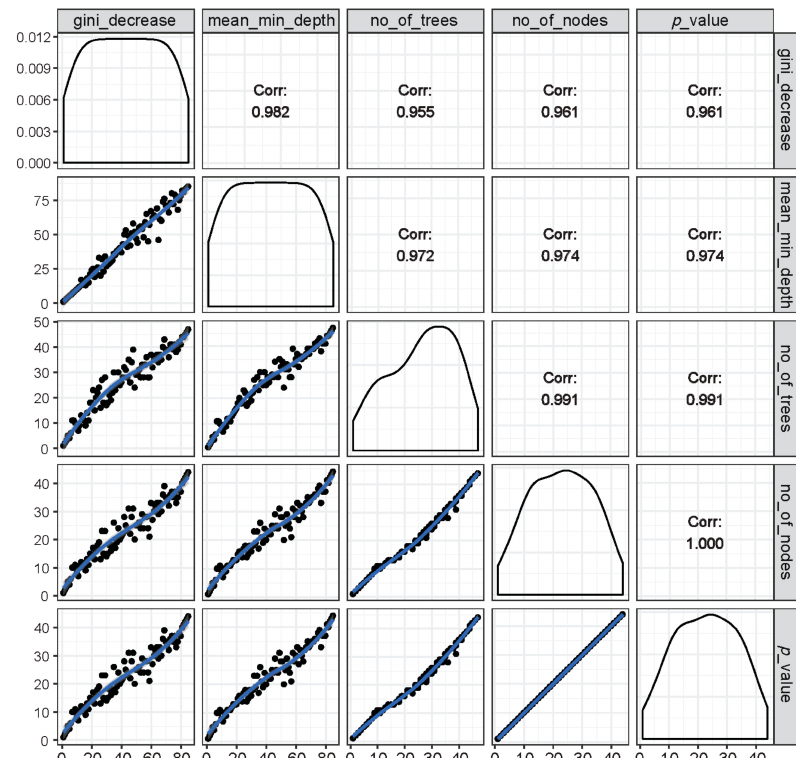
Figure 4. Illustration of rankings of variables based on any of the two RF parameters of importance (inside the left and bottom panels showing distribution of the rankings of all predictor variables marked with black dots along a blue trend line) as well as the respective correlation coe ffi cients across rankings of any two parameters (inside the right and top panels). It is shown that all RF parameters of importance were found to have very high correlations among each other, suggesting that these parameters are highly reliable at ranking the importance of variables in group